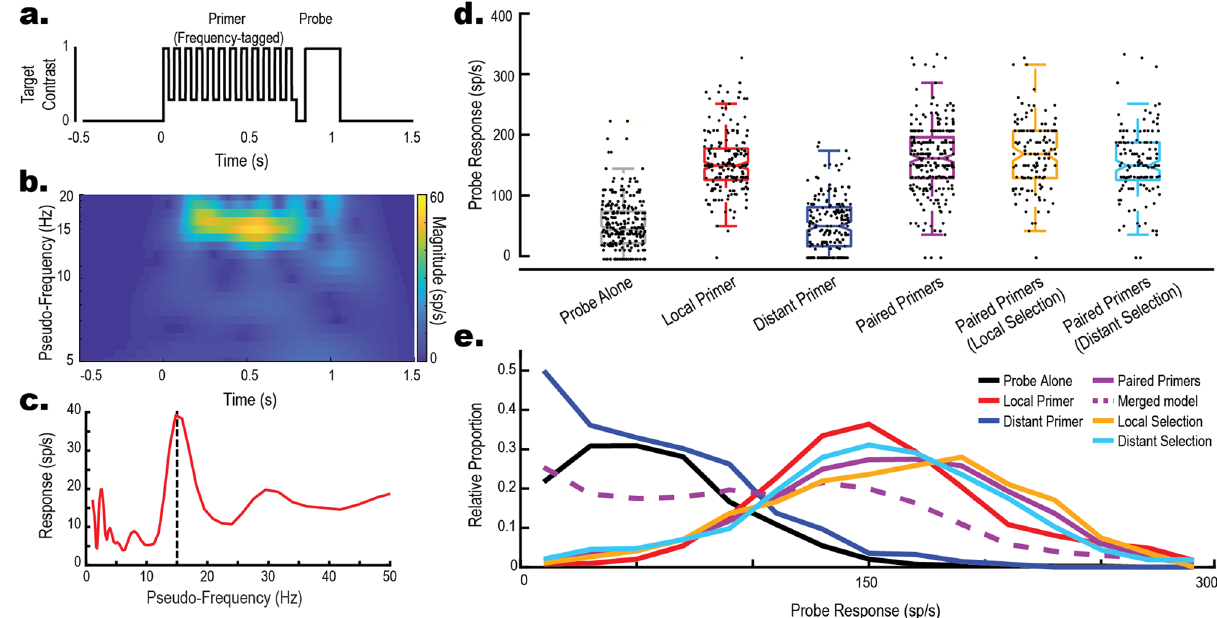
Fig. 2 Facilitation is generated on unselected trajectories. We applied frequency-tagging to Primers to determine which was selected on any individual trial. a An example of frequency-tagging with the modulation of one Primer contrast at 15 Hz before a Probe. b Wavelet scalogram of the spike activity (Inverse Interspike Interval) in response to a single example trial reveals a frequency-locked response at 15 Hz. c Time-collapsed wavelet scalogram ( b ) reveals a peak around 15 Hz. d Box-and-whisker with overlaid swarm plots illustrating Probe response, for Long (800 ms) and Short (400 ms) Primers combined (896 total trials across 15 dragon fl ies). For comparison, Probe Alone, Local, Distant and Paired Primers are shown (i.e. same data as in Fig. 1). Local Selection and Distant Selection box plots are the Paired Primers (purple) categorised by the Selectivity Index. We observe similar distributions between Local and Distant selection trials. e Frequency Polygons illustrating the distributions of each condition. Local Selection (gold) and Distant Selection (cyan) more closely match Local Primer (red) than the Merged Model (dashed purple) con fi rming that the Probe target is facilitated with either Local or Distant